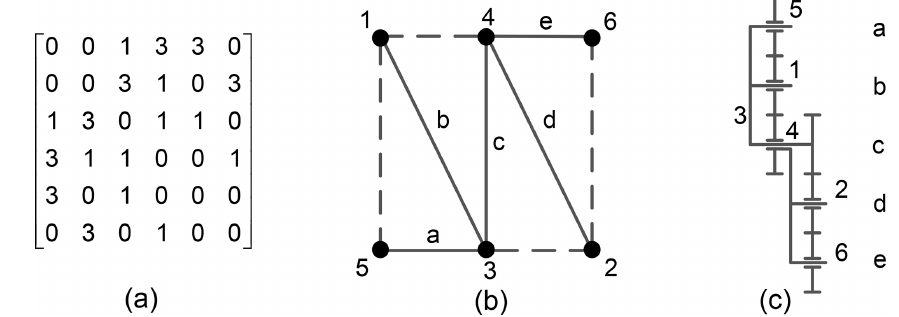
Figure 6. Case 1 of the DPGT. (a) The adjacency matrix, (b) d graph, and (c) mechanism diagram.